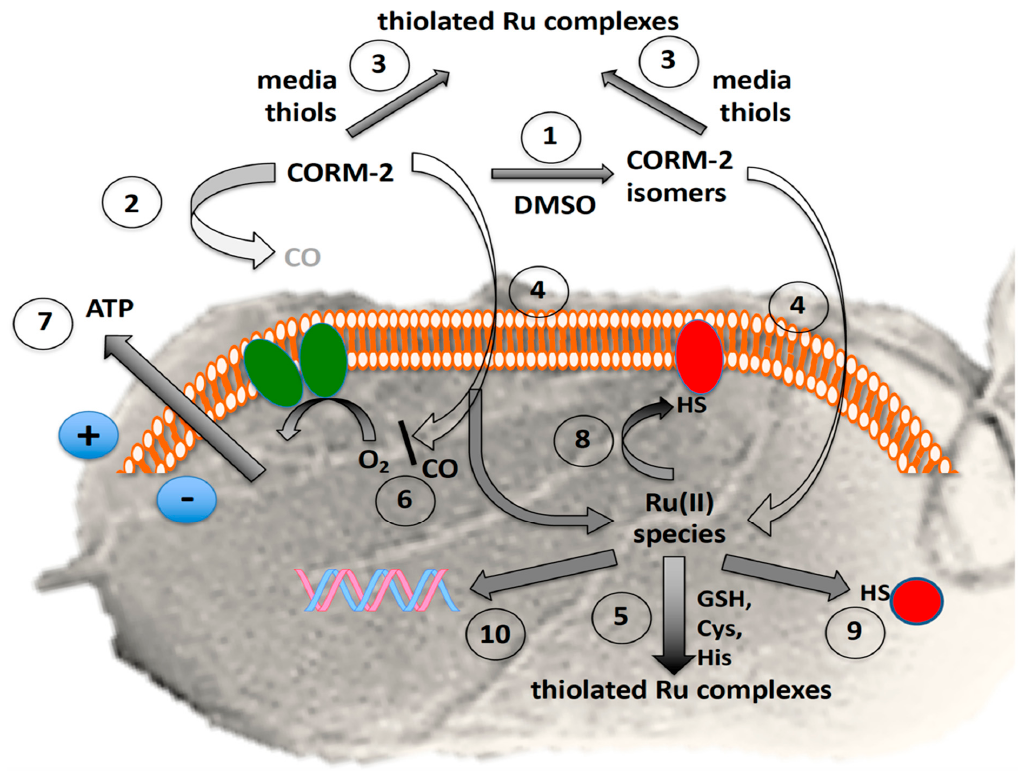
Figure 8. Complexity of the antibacterial actions of CORM-2. The grey background shows the surface view of a bacterial cell with flagella. The orange and white assembly represents phospholipid bilayer in the inner cell membrane containing the respiratory chain (green ovals) and numerous other proteins. The red shapes represent membrane and soluble proteins with exposed -SH groups (exposed histidine imidazole or methionine CH 3 S- are not shown). The blue circles show the charge separation (positive outside, i.e., the protonmotive force) established via respiratory electron transfer or ATP hydrolysis. In the presence of the solvent, DMSO, numerous species are formed by DMSO displacement (1) with low yields of CO, rapidly declining with time (2). Exogenous amino acids and thiols (especially cysteine, glutathione and N-acetyl cysteine) bind CORM-2 and thus protect bacteria from growth inhibition (3); the prevention of toxicity correlates with their CORM-2-binding affinities. CORM-2 or its derived isomers enter cells by unidentified pathways (4). Glutathione and other thiols are intracellular targets of CORM-2 (5). Residual CO inhibits terminal oxidase activity (6) but also may react with transcription factors, Fe–S clusters and other unidentified targets (not shown), leading to loss of membrane integrity and cytoplasmic ATP leakage (7). The fate of intracellular Ru(II) is complex but includes membrane (8) and other intracellular targets (9) targets, including DNA (10).